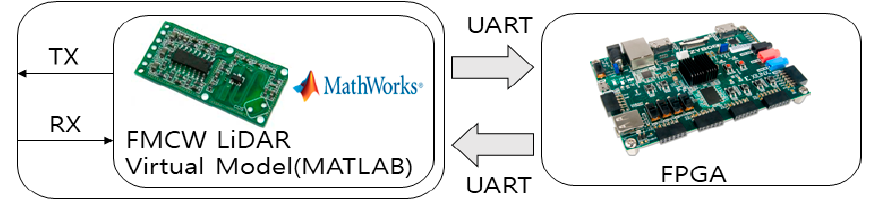
Figure 11. System configuration for experiments.